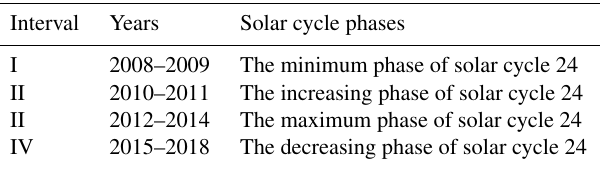
Table 2. Classification of selected years according to the solar cycle phases. Interval Years Solar cycle